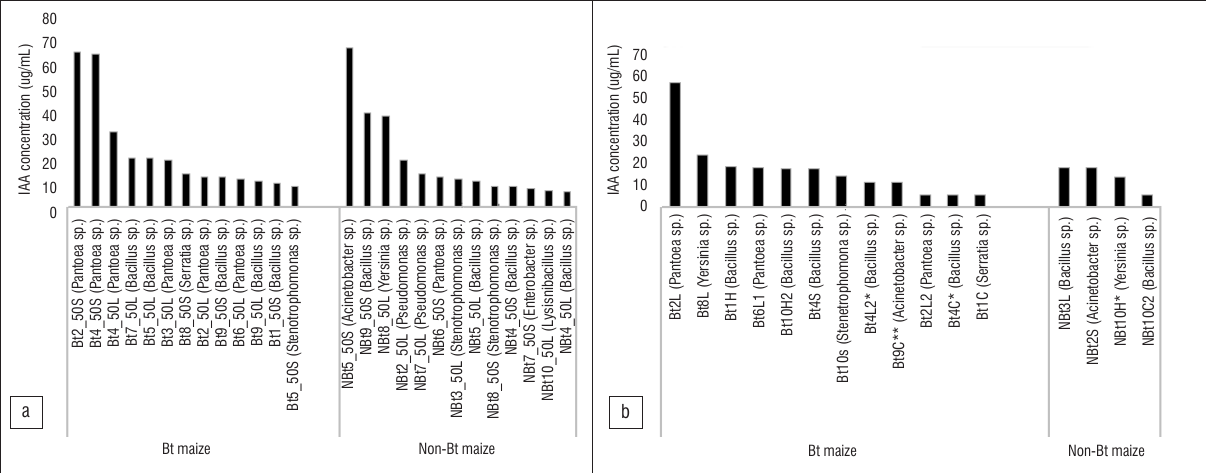
Figure 7: Estimated indole acetic acid (IAA) production of Bt and non-Bt maize endophytes in (a) 50-day-old maize isolates and (b) 90-day-old maize